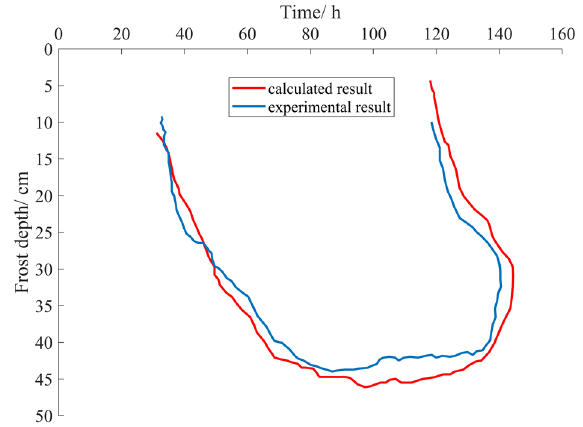
Figure 10. Time-history curves of the frost depth.